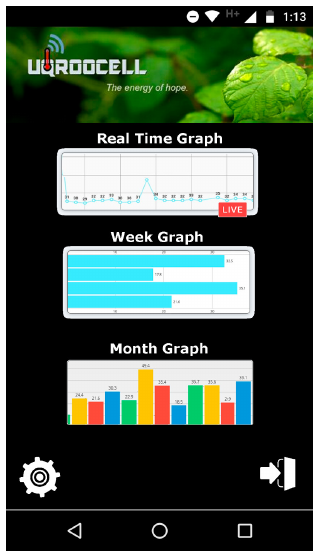
Figure 12. IoT Application: web-based supervision